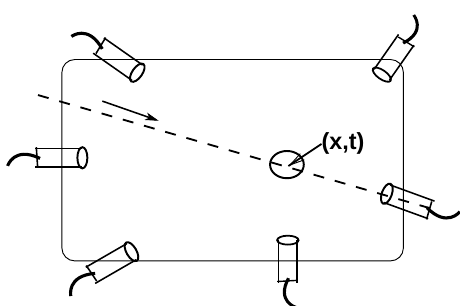
Figure 1. A chamber to observe electrons ejected by a passing heavy